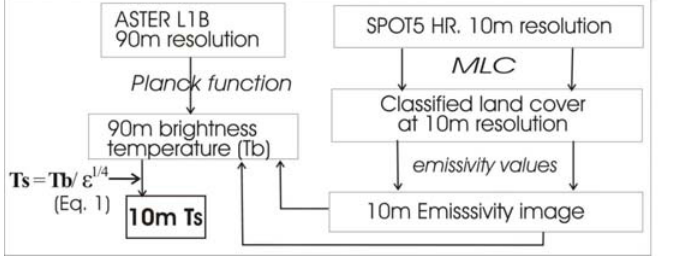
Figure 2. The Emissivity Modulation procedure: an emissivity image from classification of a SPOT 5 image with 10 m resolution is combined with a 90 m ASTER image of brightness temperature. Emissivity values are derived from the MODIS emissivity library.